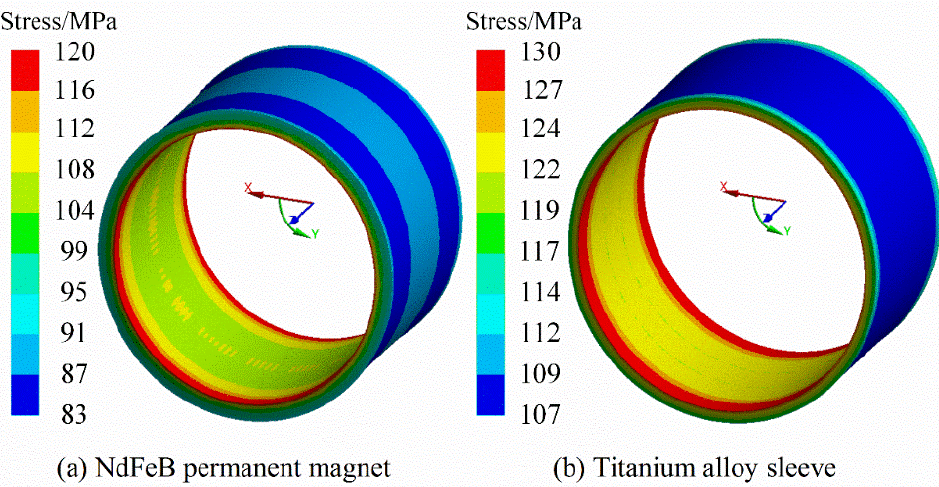
Figure 23. Rotor stress by coupled temperature-stress model. ( a ) NdFeB PM stress, ( b ) Sleeve.